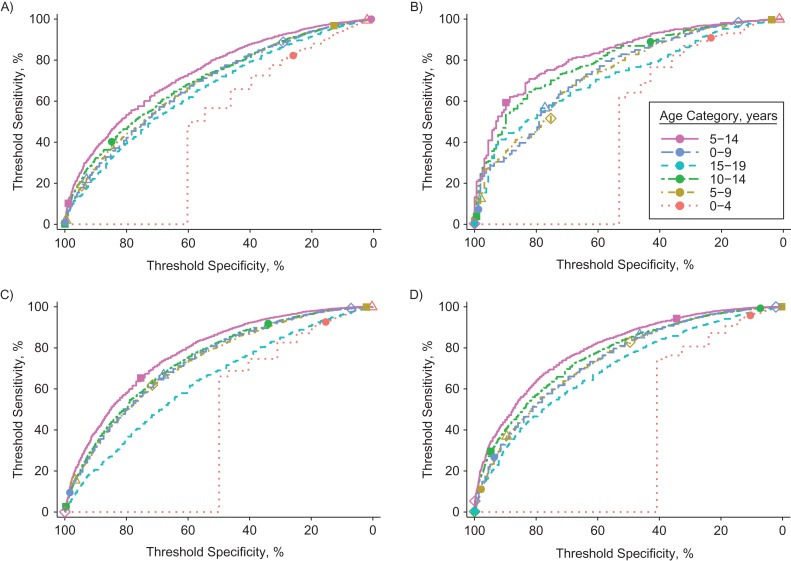
Receiver operating characteristic curve for Ov16 antibody prevalence as a predictor of onchocerciasis elimination. The panels represent 4 examples out of 750 scenarios of precontrol community microfilarial load (CMFL) and history of mass drug administration (MDA). See Figure 1 for a description of how the receiver operating characteristic curves were created. Colored lines represent the Ov16 prevalence measured in different age categories. Symbols represent different threshold values for Ov16 antibody prevalence: 2% (open circle), 5% (open triangle), 10% (open diamond), 25% (solid square), and 50% (solid circle). Ov16 positivity is assumed to be lifelong, but patterns are qualitatively similar when based on the assumption of instant seroreversion. See Web Figure 1 for a complete overview of all 750 scenarios considered and both assumptions about Ov16 seroreversion. A) Precontrol CMFL of 10 microfilariae (mf) per skin snip and 8 rounds of MDA at 60% coverage, resulting in an overall probability of elimination of 82.6%. B) Same scenario as in A, but with 10 instead of 8 MDA rounds, resulting in an overall probability of elimination of 98.4%. C) Precontrol CMFL of 55 mf per skin snip and 13 rounds of MDA at 80% coverage, resulting in an overall probability of elimination of 27.6%. D) Same scenario as in C, but with 15 instead of 13 MDA rounds, resulting in an overall probability of elimination of 70.2%.